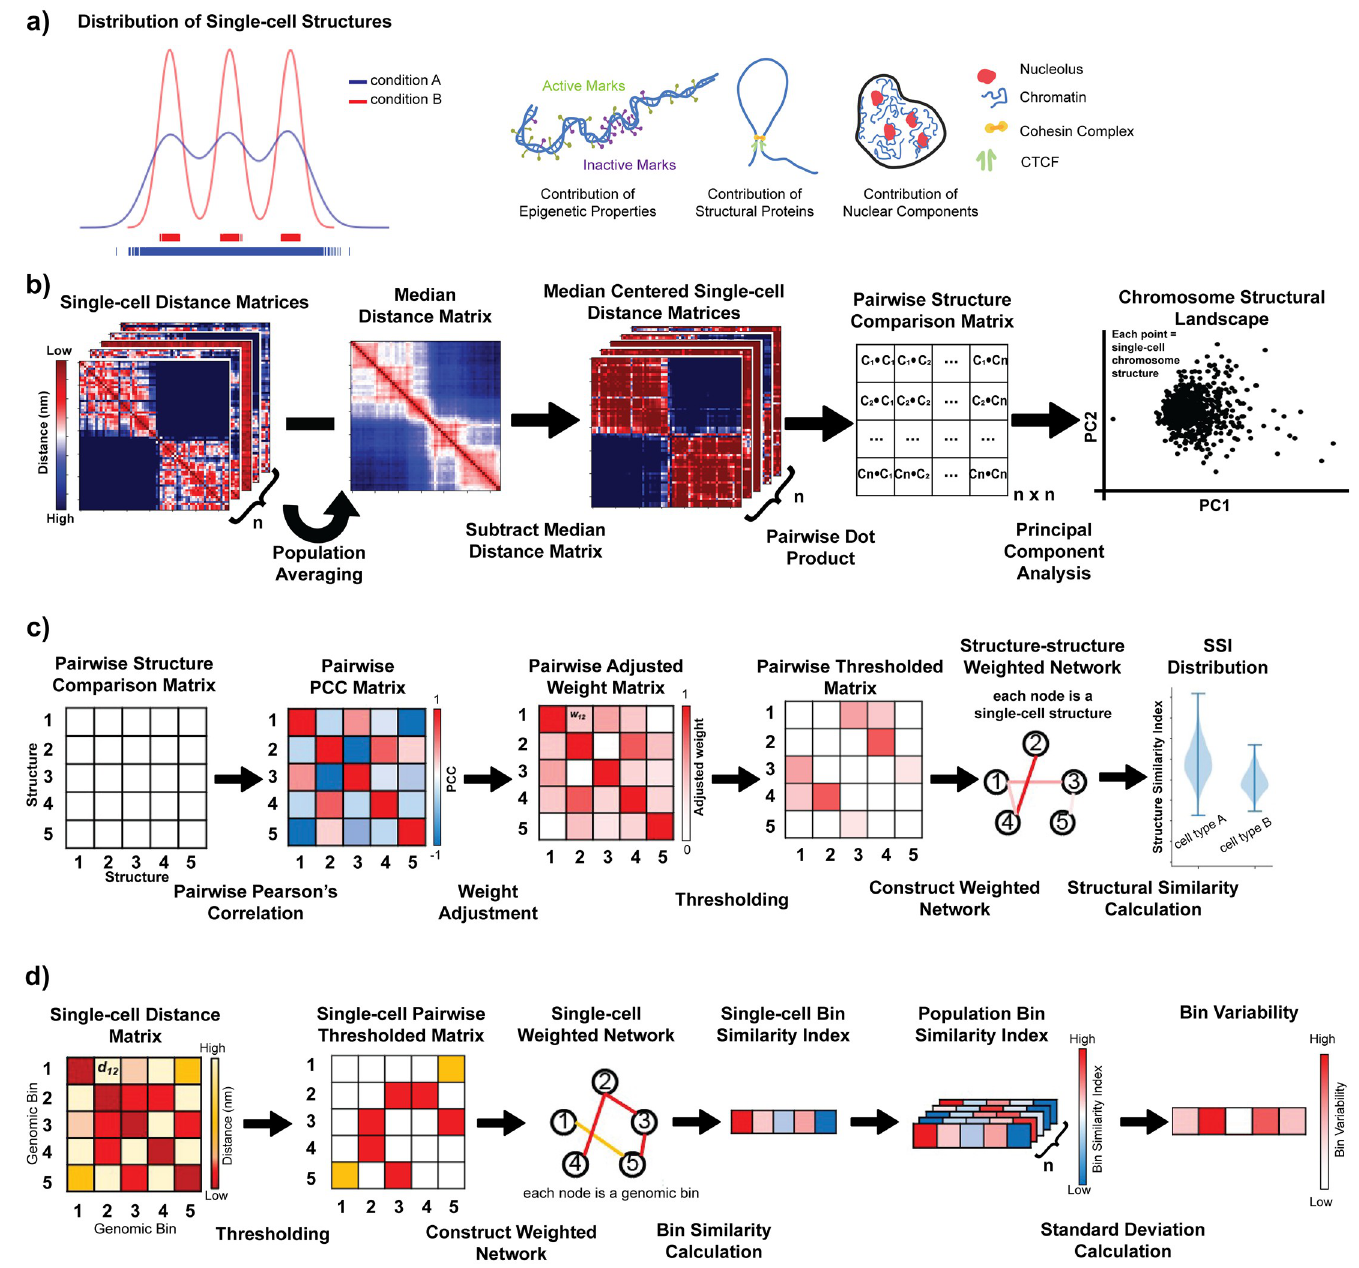
Fig 1. Schematic representation of the statistical pipeline used to quantify conformational diversity present in single-cell chromosome distance matrices. a) Cartoon representation of potential differences in chromosome structure landscapes (left). Condition A has a continuous landscape including all structures along a trajectory, while in Condition B, chromosomes fall into 3 major structural clusters. (Right) Conditions and factors that may influence this chromosome structure landscape. b) Each pair of median-centered chromosome distance matrices are compared in a pairwise fashion. PCA is then performed on the pairwise structure comparison matrix and transformed data is projected in 2D space using PC1 and PC2 to create the “chromosome structural landscape”. c) To calculate chromosome ensemble structure similarity index (SSI), we construct a Pearson’s correlation matrix from the pairwise structure comparison matrix. This correlation matrix scaled, thresholded, and then converted into a weighted network from which SSI values can be calculated from each node. The median SSI value is plotted for many resamplings of nodes. d) To calculate bin variability, we convert each single-cell distance matrix into a thresholded matrix using a cutoff and then construct a network from each of those matrices with bins as nodes and contacts between bins as edges. We then calculate the bin similarity index for each bin in each single-cell and then take the standard deviation of the bin similarity index across the population as the bin variability.